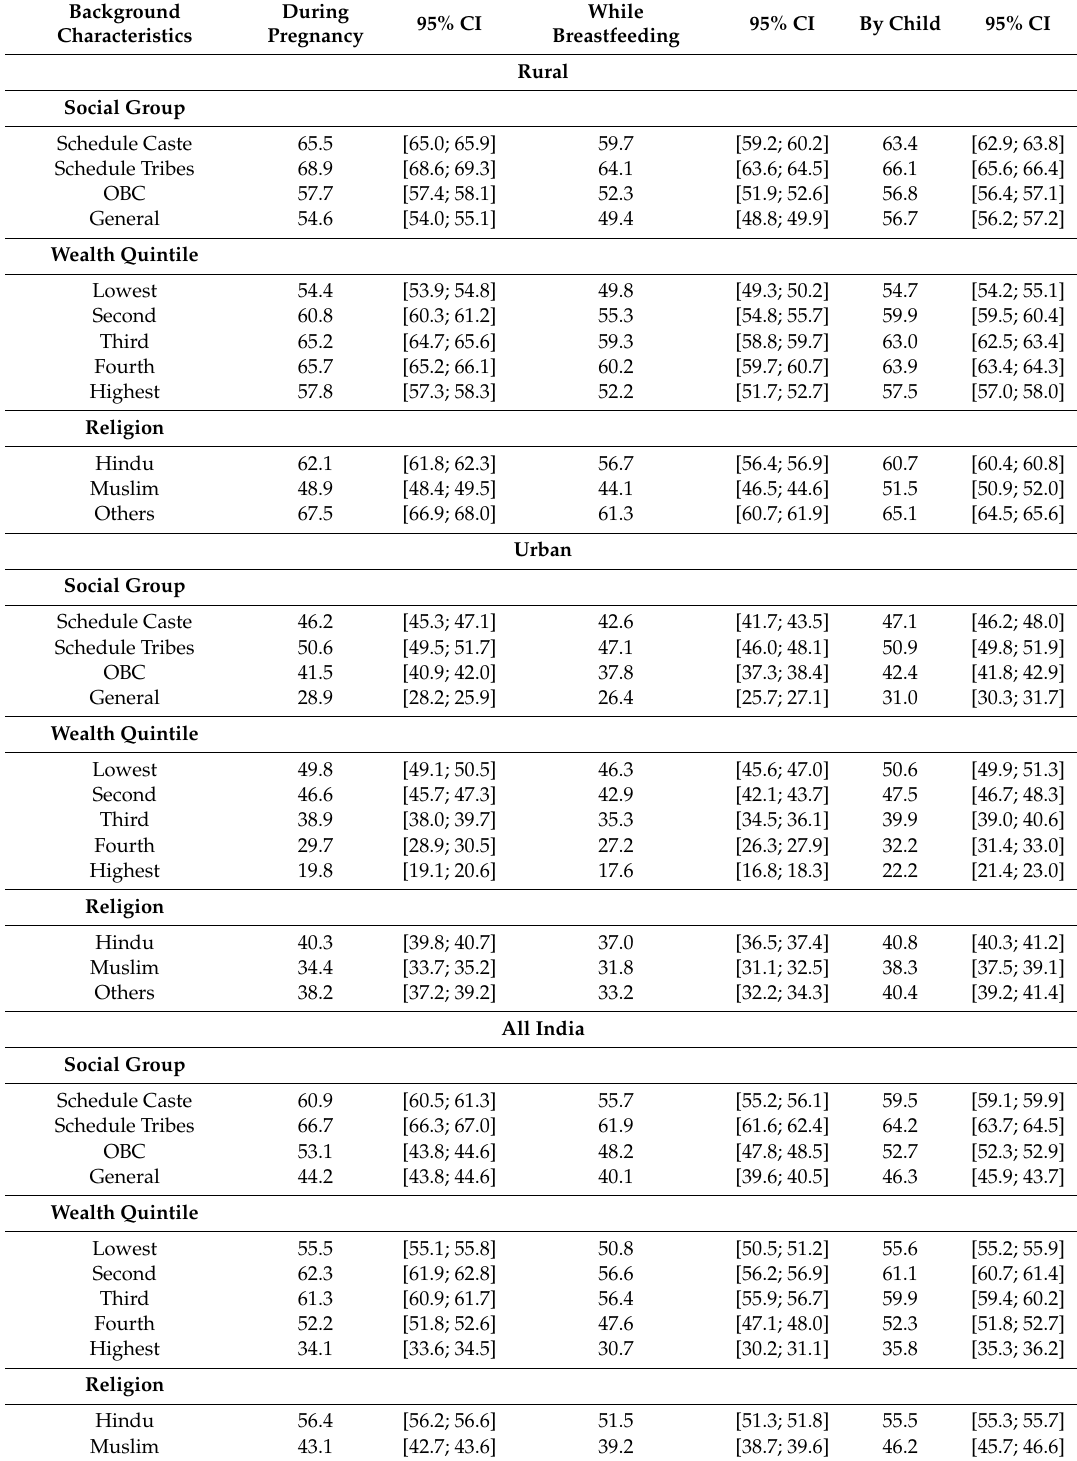
Table 2. Utilization of ICDS services (any) by mothers (during pregnancy and while breastfeeding) and children under six years, India by Socioeconomic Background, NFHS,